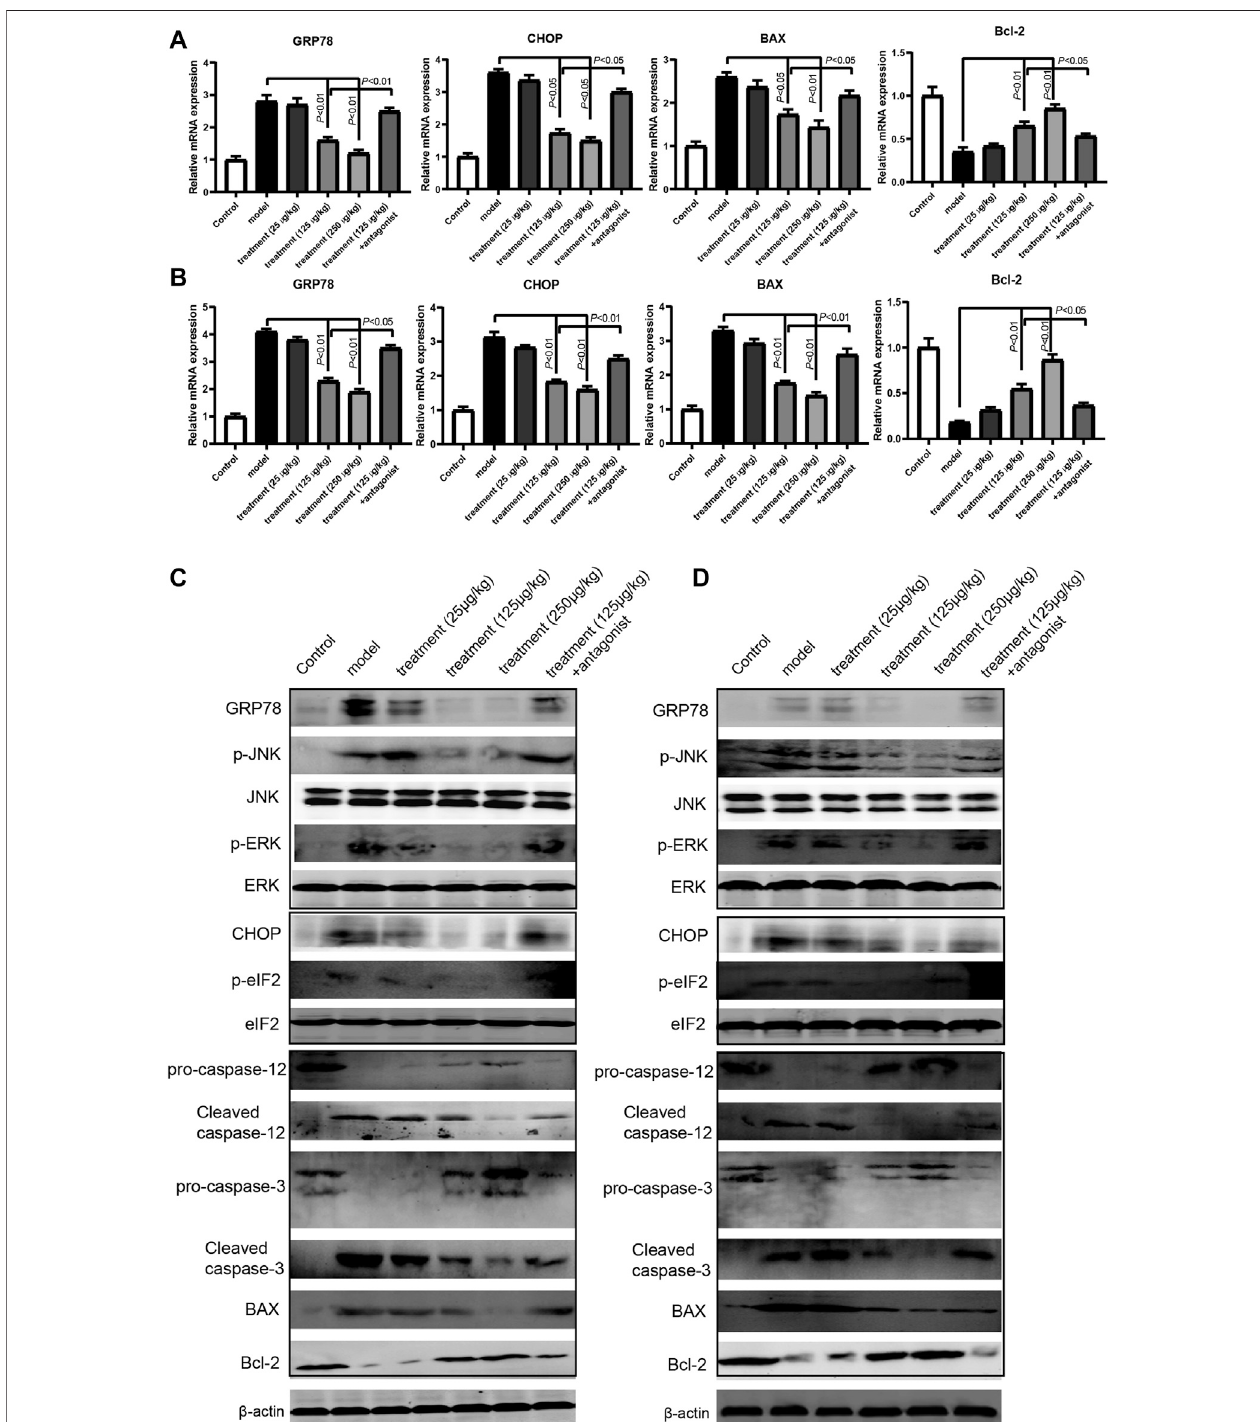
FIGURE 4 | Ghrelin regulated UPR pathway and apoptosis in intestine tissues of model mice. (A ) and (B) RT-qPCR analysis of the expression levels of GRP78, CHOP,BAX,andBcl-2intheDDSmodelandTNBSmodel.Datawereshownasmeans ± SD(n (cid:2) 3).** p < 0.01comparedtoDSSorTNBSgroup.& p < 0.05compared toghrelin (250 μ g/kg) group.&& p < 0.01compared toghrelin(250 μ g/kg)group. (C) WesternblotanalysisofGRP78,phospho-JNK,phosphor-ERK,CHOP, phospho- eIF2, caspase-12, caspase-3, BAX, and Bcl-2 in the DSS model. (D) Western blot analysis of GRP78, phospho-JNK, phosphor-ERK, CHOP, phospho-eIF2, caspase-12, caspase-3, BAX, and Bcl-2 in the TNBS model.